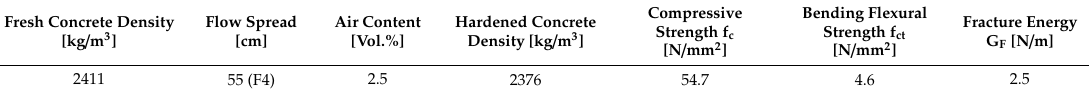
Table 7. Concrete properties of (1) CEM V/A (S-V) 32.5 R cement type and calcareous schist aggregate.